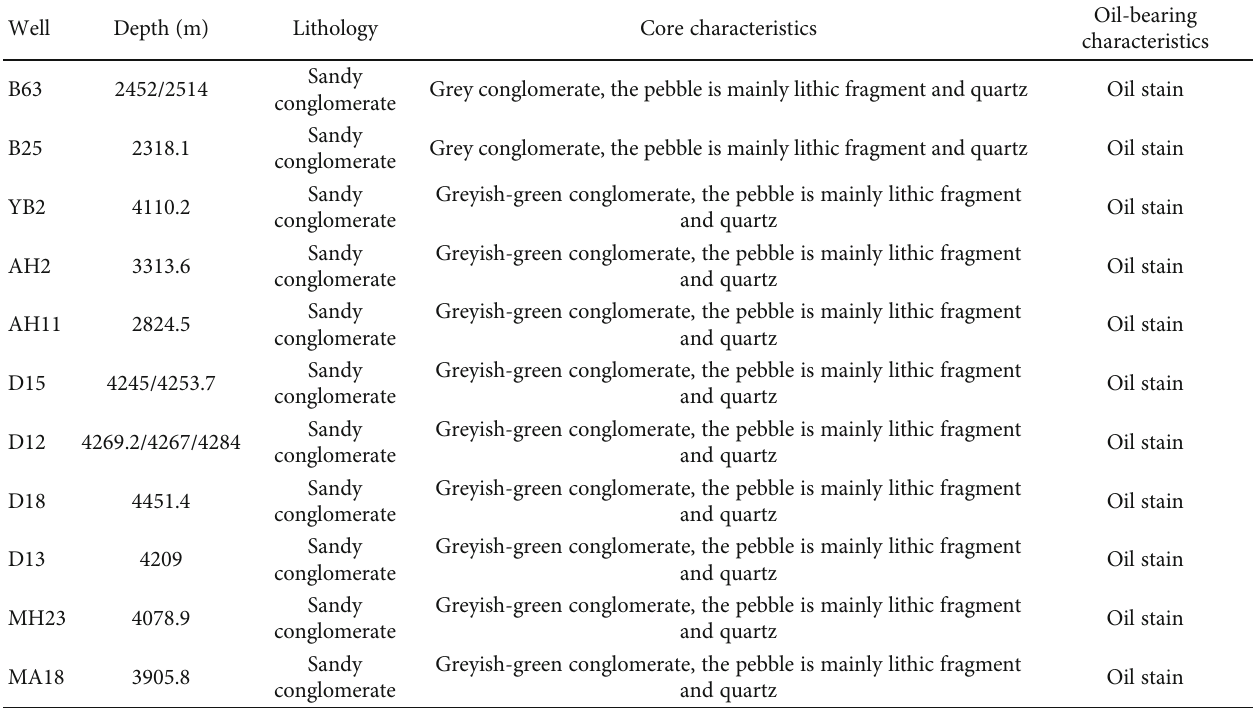
Table 1: Basic features of the Triassic Baikouquan Formation reservoir samples from the Mahu Sag, Junggar Basin. Well Depth (m)